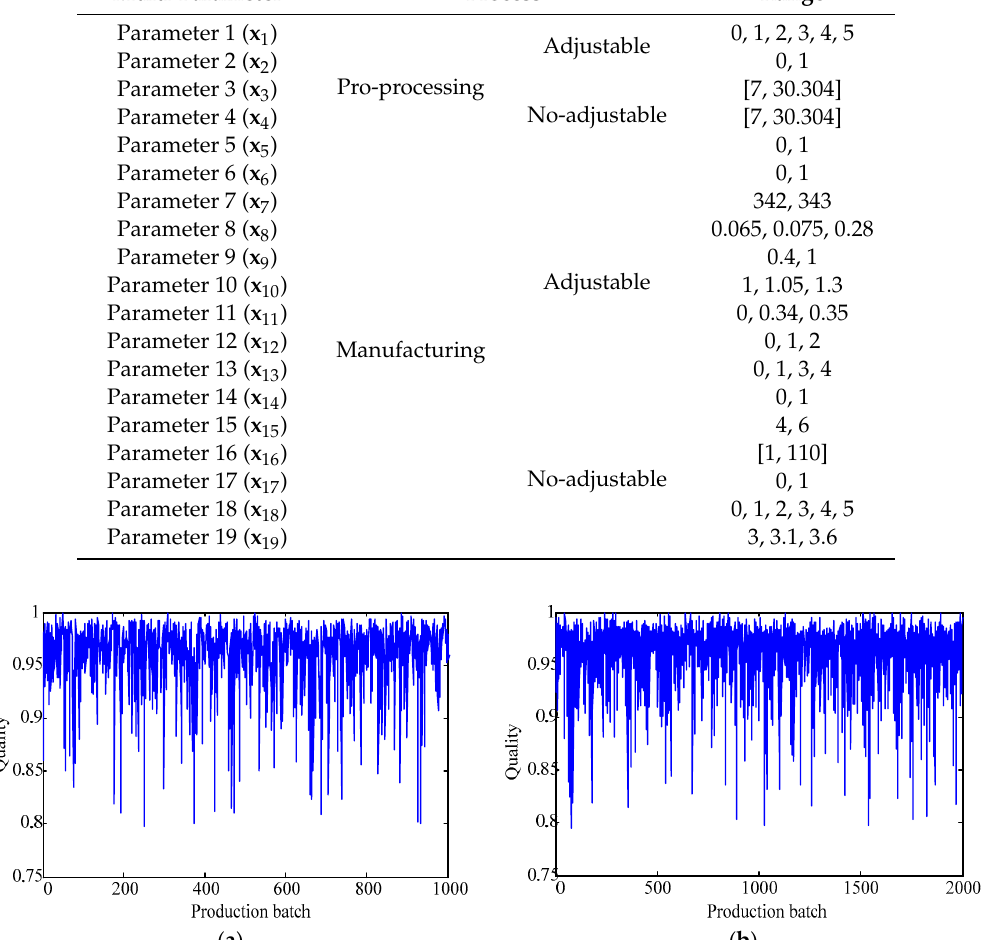
Table 1. Statistical information of the multi-parameter in di ff erent processes.